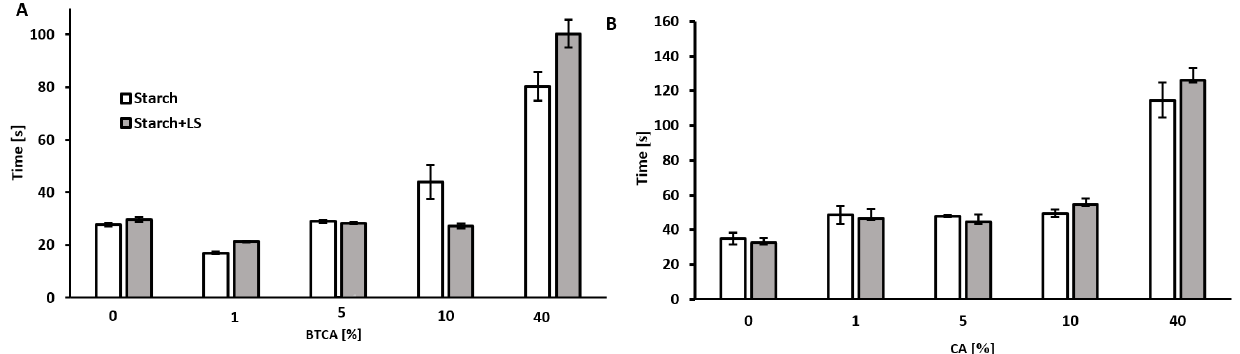
Figure 2. Bonding times of the starch-based adhesive, with and without enzymatically polymerized LS (8%), and containing different amounts of BTCA ( A ) and CA ( B ). Error bars indicate the standard deviation (n = 3).